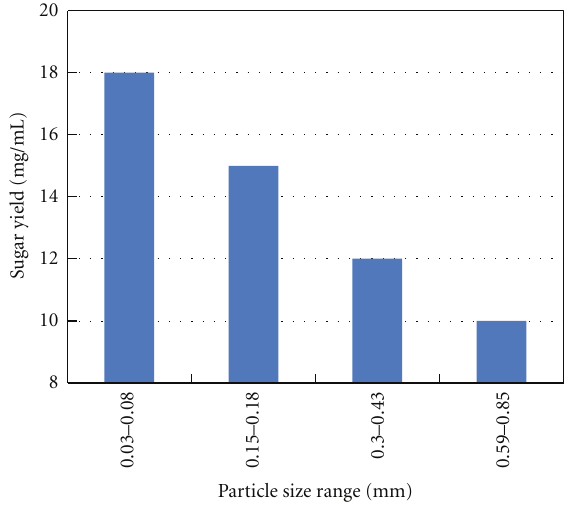
Figure 15: E ff ects of particle size on sugar yield reported by Dasari and Berson